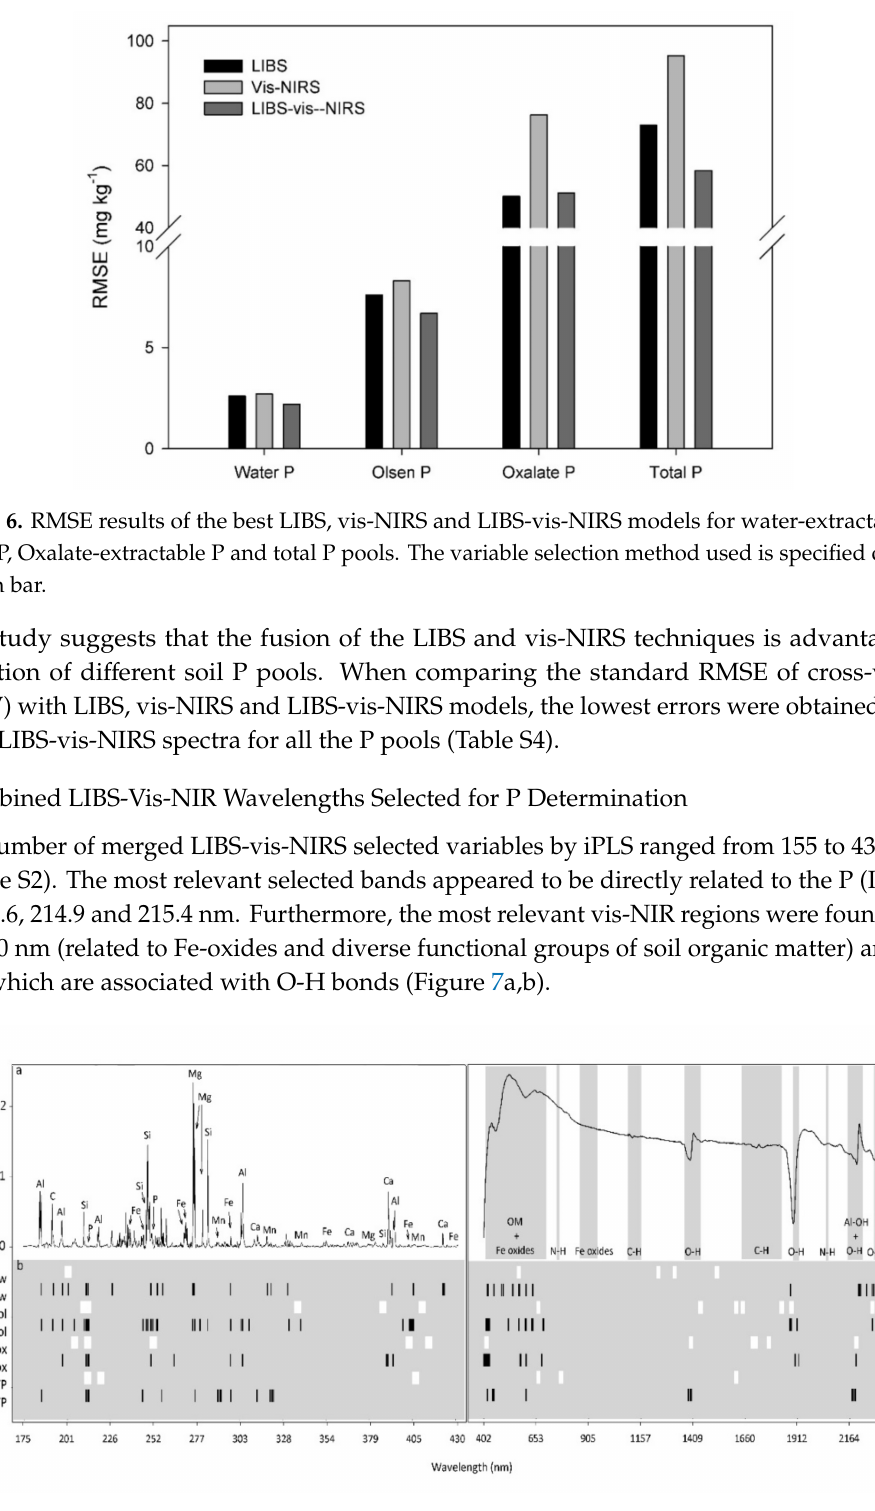
Figure 7. Representative LIBS-Vis-NIR-corrected spectra with elements marked above their associated emission lines and associated absorption bands for the di ff erent bonds present in soil ( a ) and selected variable regions ( b ) by iPLS (white) and CARS (black) for water-extractable P (Pw), Olsen P (Pol), Oxalate-extractable P (Pox) and total P